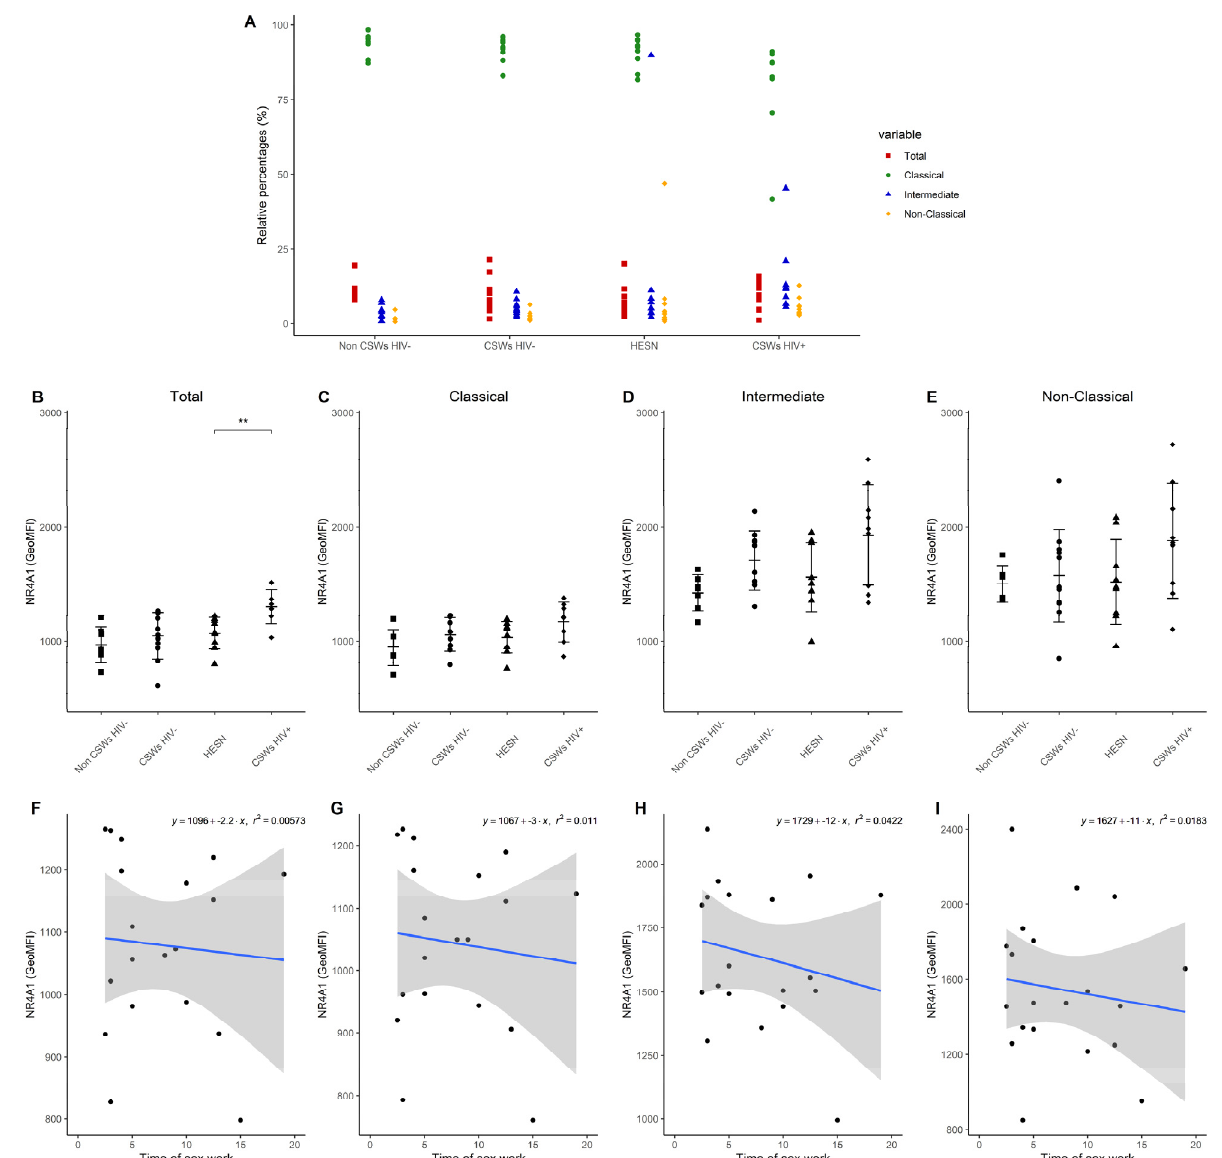
Figure 2. Flow cytometry analyses of relative frequencies of live blood monocyte populations and NR4A1 protein expression levels. ( A ) Relative frequencies of CD14+CD16 − classical, CD14+CD16+ intermediate, and CD14 low/dim CD16++ non-classical monocyte populations were calculated vs. total live CD14+ monocytes. ( B – E ) Levels of expression of NR4A1, as determined by geometric mean fluorescence intensity (GeoMFI), by ( B ) total, ( C ) classical, ( D ) intermediate, and ( E ) non-classical monocytes. Data are presented as the mean value ± SD of samples from 7 non-CSWs HIV- (HIV-1-uninfected control women from the general population), 9 CSWs HIV- (HIV-1-uninfected 2.5–5-year CSWs “early HESNs”), 11 HESNs (HIV-1-uninfected ≥ 10 years CSWs), and 9 CSWs HIV+ (HIV-1-infected CSWs). Significance levels are shown as * ( p < 0.05), ** ( p < 0.01), *** ( p < 0.001). ( F – I ) Linear regression analyses are shown for CSWs HIV- (HIV-1-uninfected 2.5–5-year CSWs “early HESNs”) and HESNs (HIV-1-uninfected ≥ 10 years CSWs).